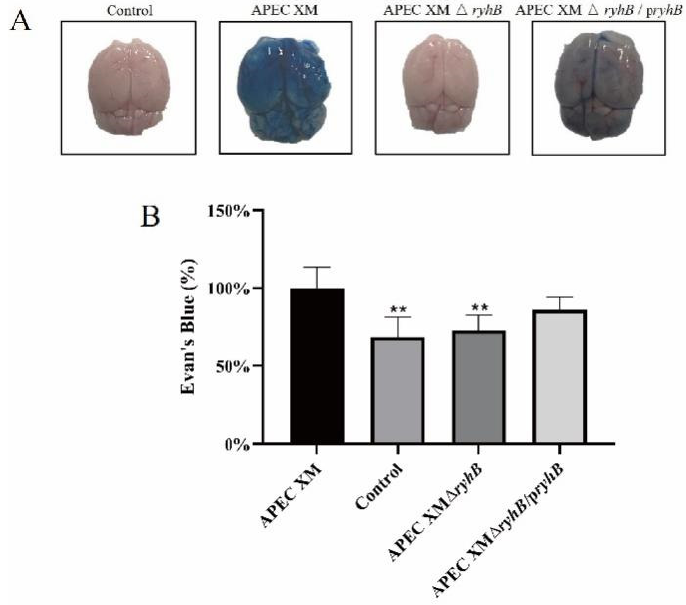
Figure 10. The integrity determination of blood-brain barrier by EB staining. ( A ) The dorsal view of brains after EB injection. ( B ) Quantification of EB that penetrated the brain. The amount of EB was calculated by measuring the absorbance at 630 nm. The data of the APEC XM group were set as 100%. Data were analyzed with SPSS 17.0 software using one-way ANOVA. Error bars represent the standard errors of the means. Significant differences between the APEC XM and APEC XM ∆ ryhB are indicated (**, p < 0.01).